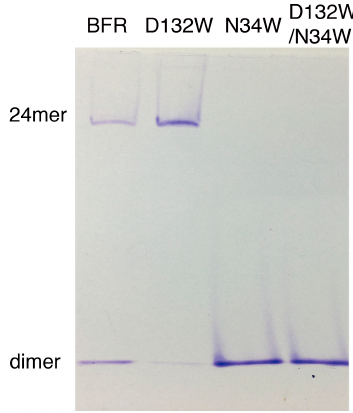
Figure 3. Native PAGE of BFR wild type and three mutants, corresponding to the result of the SEC experiment.